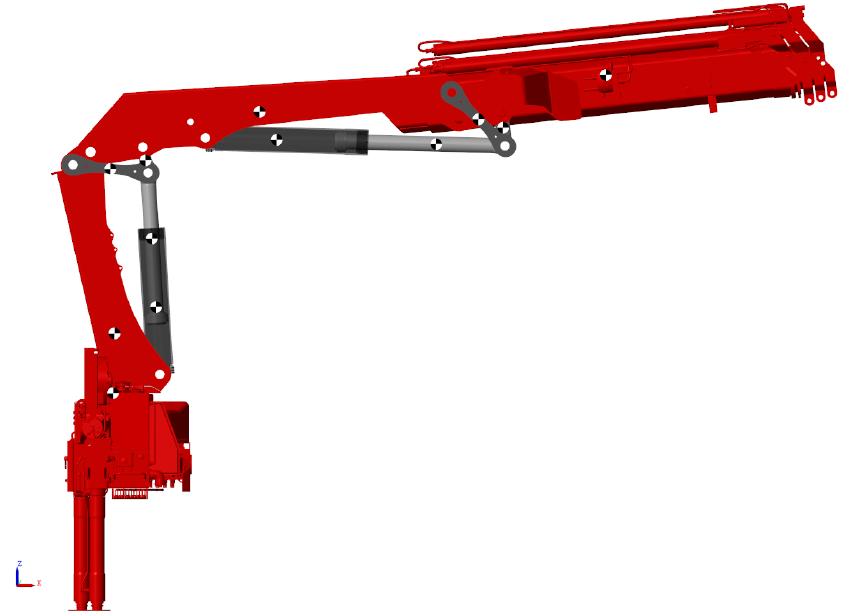
Figure 10. 3D view of the simulation model of the HMF 2020K4 in Simscape.